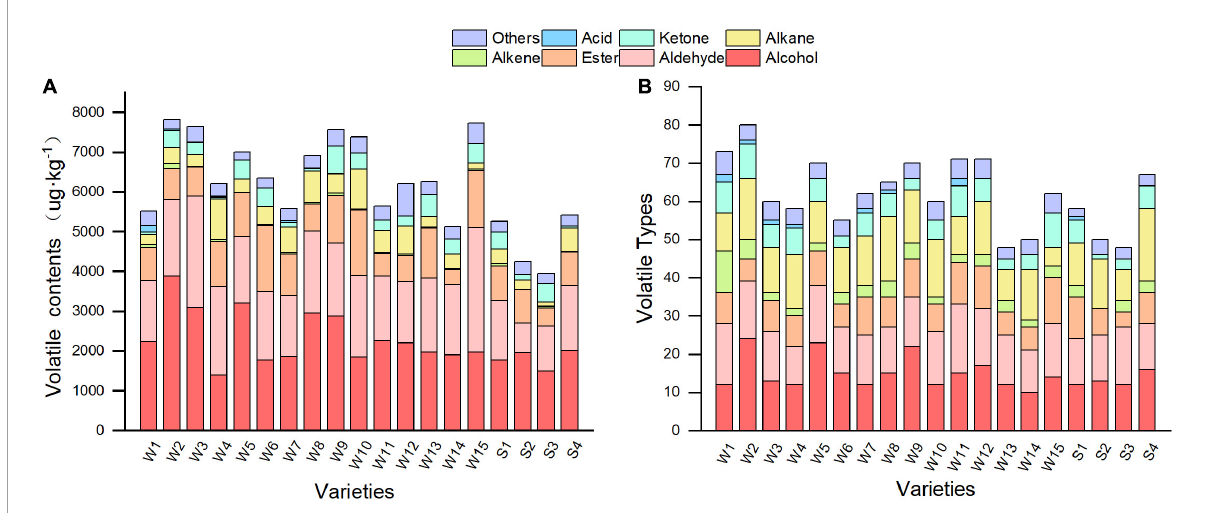
FIGURE6 Content (A) and type (B) of volatile compounds in pepper. W1, Fengshouxianjiao; W2, Sujiao 8; W3, Qingan 7; W4, Sujiao 18; W5, Longjiao 2; W6, Longjiao 10; W7, Longjiao 11; W8, Huamei 105; W9, 37–124; W10, 3F*106; W11, Tianjiao 20; W12, Tianjiao 23; W13, Hangjiao 2; W14, Hangjiao